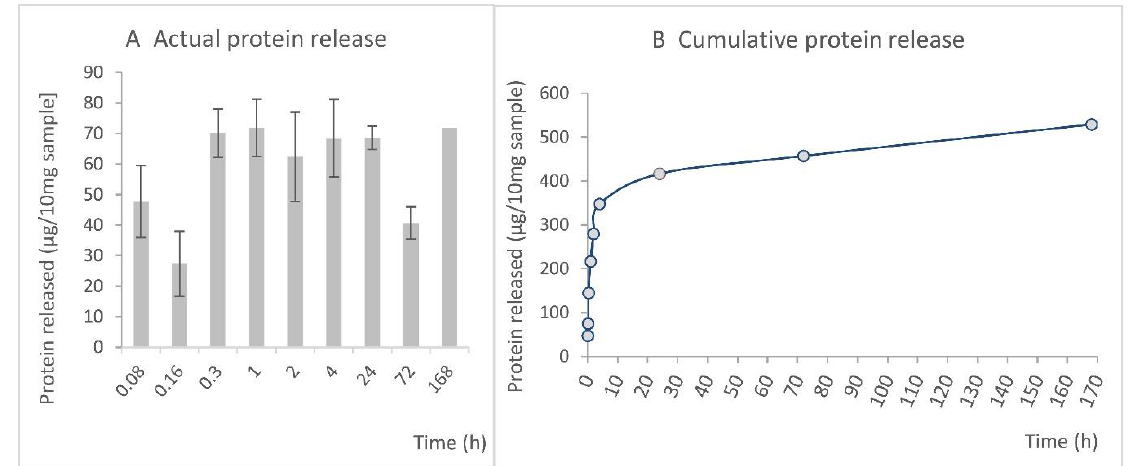
Figure 3. Actual protein concentration ( A ) and cumulative protein release ( B ) from the PVA–PL nanomats during a 7-day incubation in phosphate-buffered saline (PBS), data expressed as mean ± Standard Deviation (S.D.) ( A ), mean ± Standard Error of Mean (S.E.M.) (B).